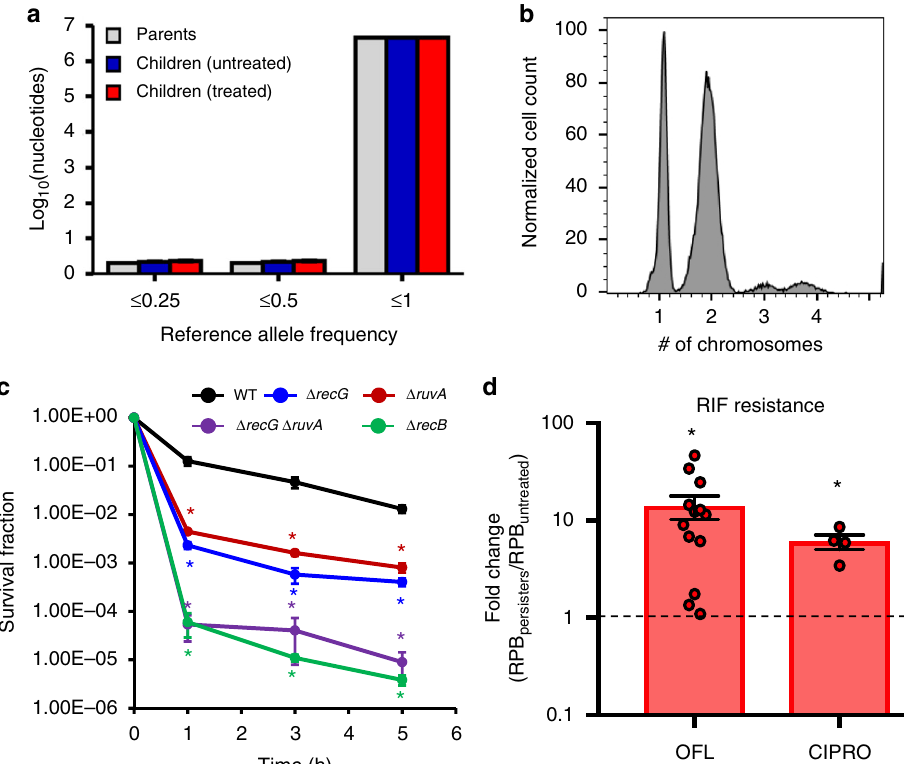
Fig. 5 Fidelity of DNA repair in OFL persisters. a WGS was performed from DNA extracted from 10 persisters, 10 untreated controls, and 4 parental cultures, and number of nucleotides with reference allele frequencies (RAF) less than or equal to the indicated values are depicted in the histogram. RAF of 1 indicates that all sequencing reads of that nucleotide were of the reference nucleotide, whereas RAF of 0 indicates that all sequence reads had a non- reference nucleotide. Values between 0 and 1 indicate that some reads were of the reference nucleotide. The RAFs at different thresholds were indistinguishable among the persisters, untreated controls, and parental cultures, suggesting that OFL persisters generally repair DNA damage correctly. b Chromosomal content of stationary-phase cultures prior to OFL treatment was determined using PicoGreen stains ( n = 3; see Supplementary Fig. 8i for controls used to determine fl uorescence intensities corresponding to chromosome number). 30.8 ± 1.6% of cells contained one chromosome,